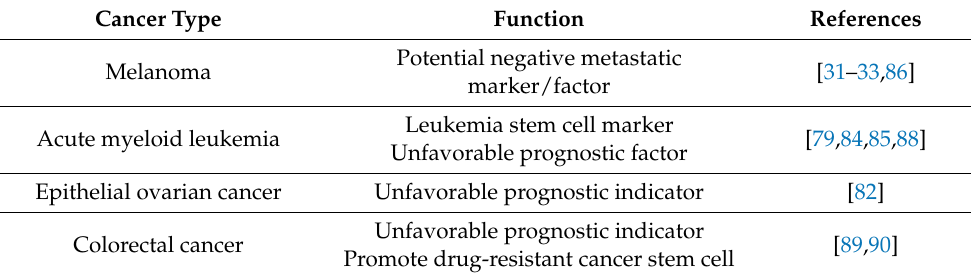
Table 1. ADGRG1/GPR56 as a cancer marker and/or prognostic